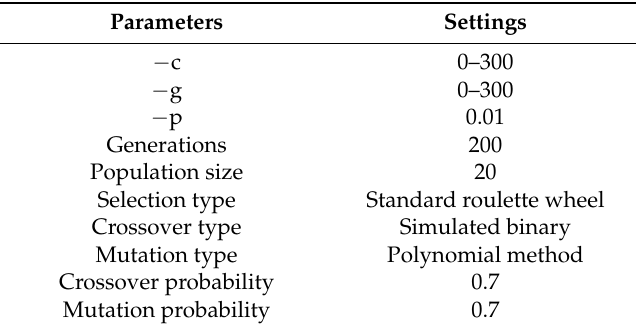
Table 1. Parameters setting of genetic